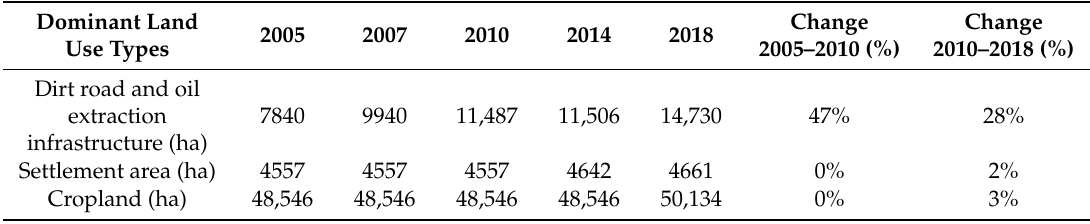
Figure 6. Variable importance for linear feature prediction in Landsat ETM+.